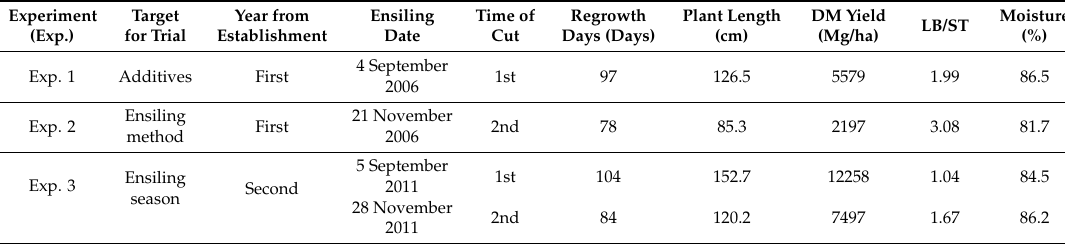
Table 1. Regrowth days, Plant length, dry matter (DM) yield, ratio of leaf blade to stem with leaf sheath (LB/ST) and moisture concentration at ensiling of dwarf napiergrass (Experiments 1–3). Experiment